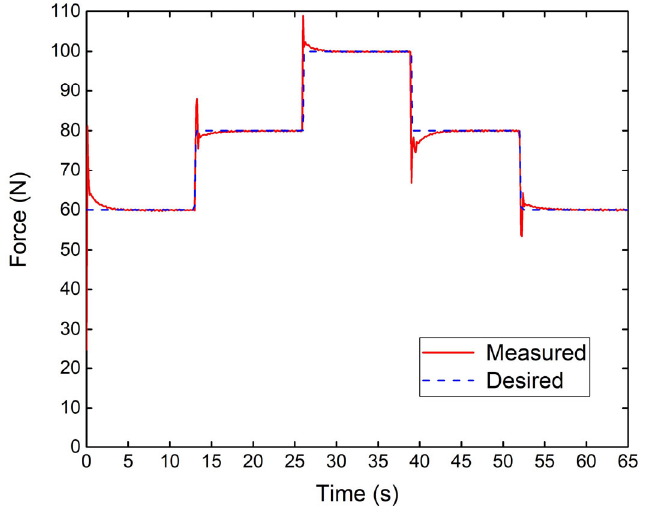
Figure 14. Tracking performance of feedforward control and PID control with a step ‐ like trajectory.